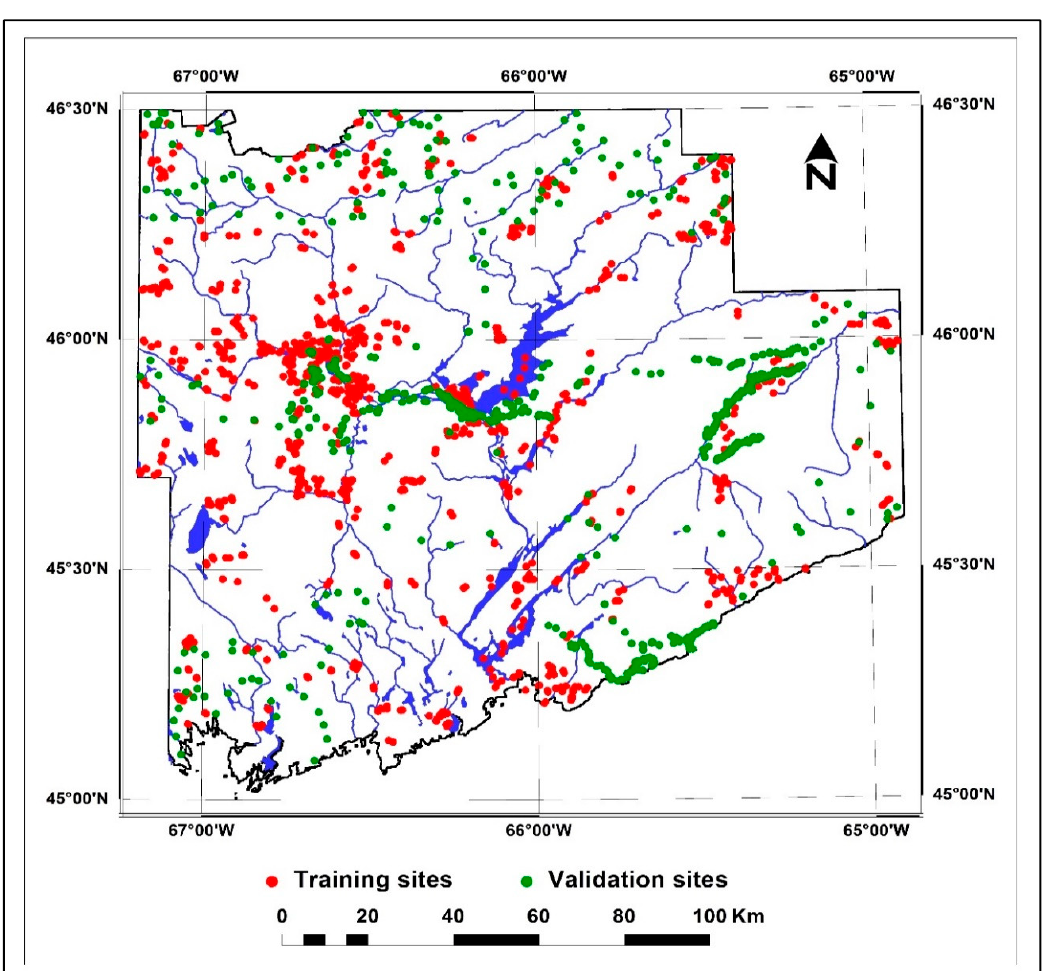
Figure 2. Location of the ground truth sites in the study area.